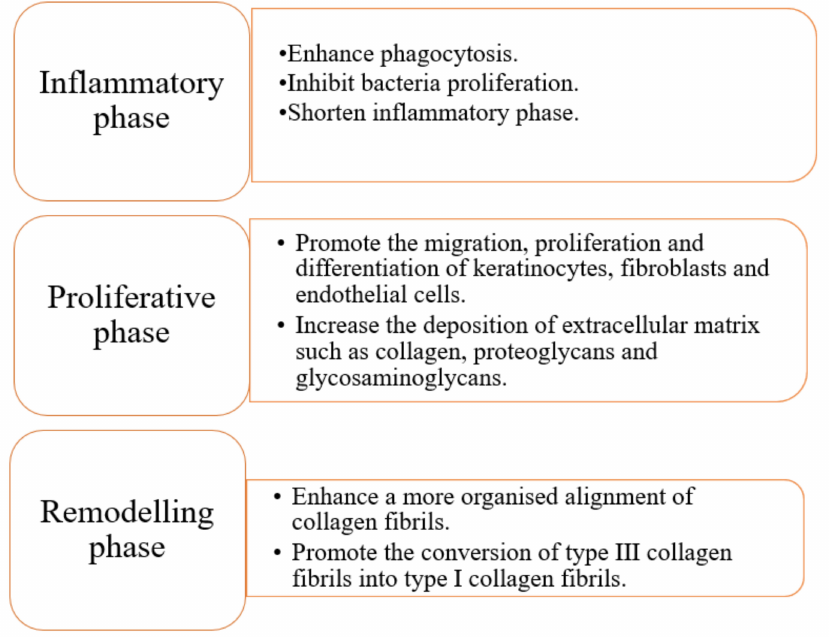
Figure 3. The effects of ES on the major outcomes of wound